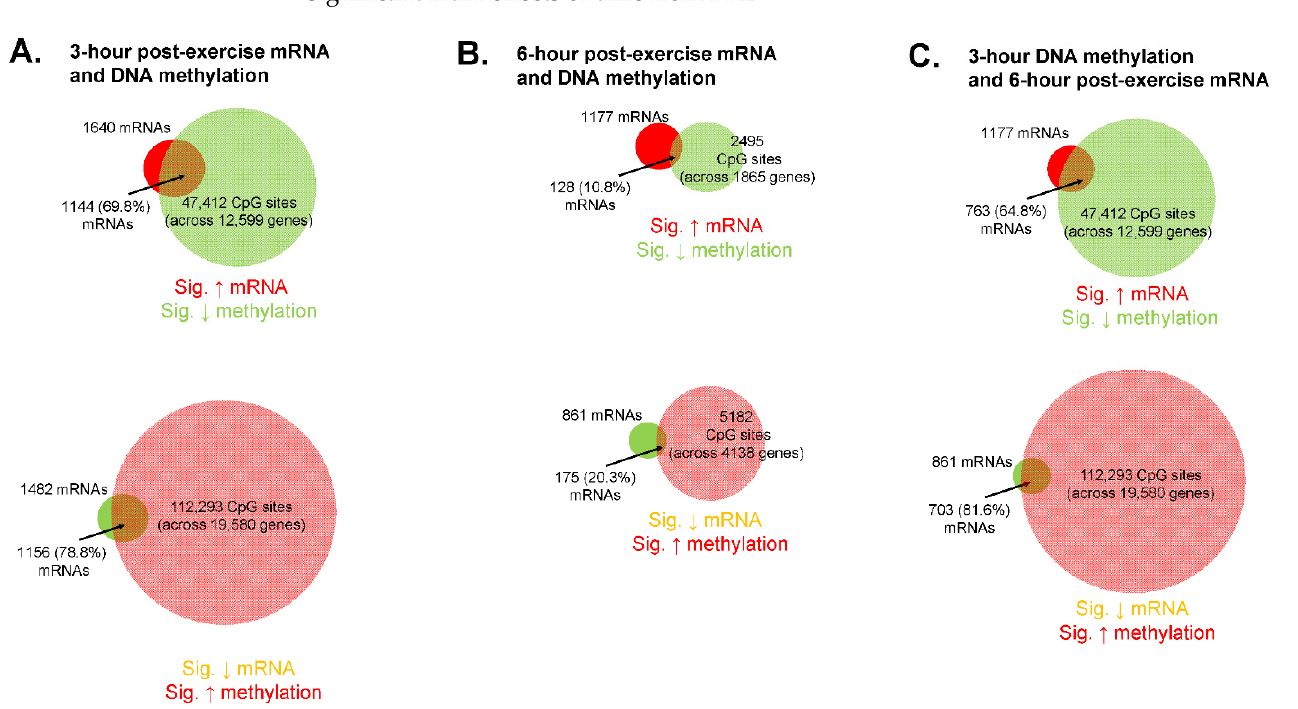
Figure 7. Transcriptome and methylation signatures overlayed. Venn diagrams illustrating mRNAs and DNA methylation values that showed significant main effects of time from PRE where red circles indicate targets that were up-regulated from PRE to 3-/6-h and green circles indicate targets that were down-regulated from PRE to 3-/6-h. Panel A contains significantly altered targets from PRE to 3 h post-exercise only. Panel B contains significantly altered targets from PRE to 6 h post-exercise only. Panel C contains DNA methylation alterations that occurred from PRE to 3 h post-exercise and mRNA expression alterations from PRE to 6 h post-exercise. Data are from n = 11 participants, differentially methylated CpG sites were considered significantly altered from PRE if p < 0.01, and mRNAs were considered significantly altered from PRE if ± 1.5 fold-change ( p <